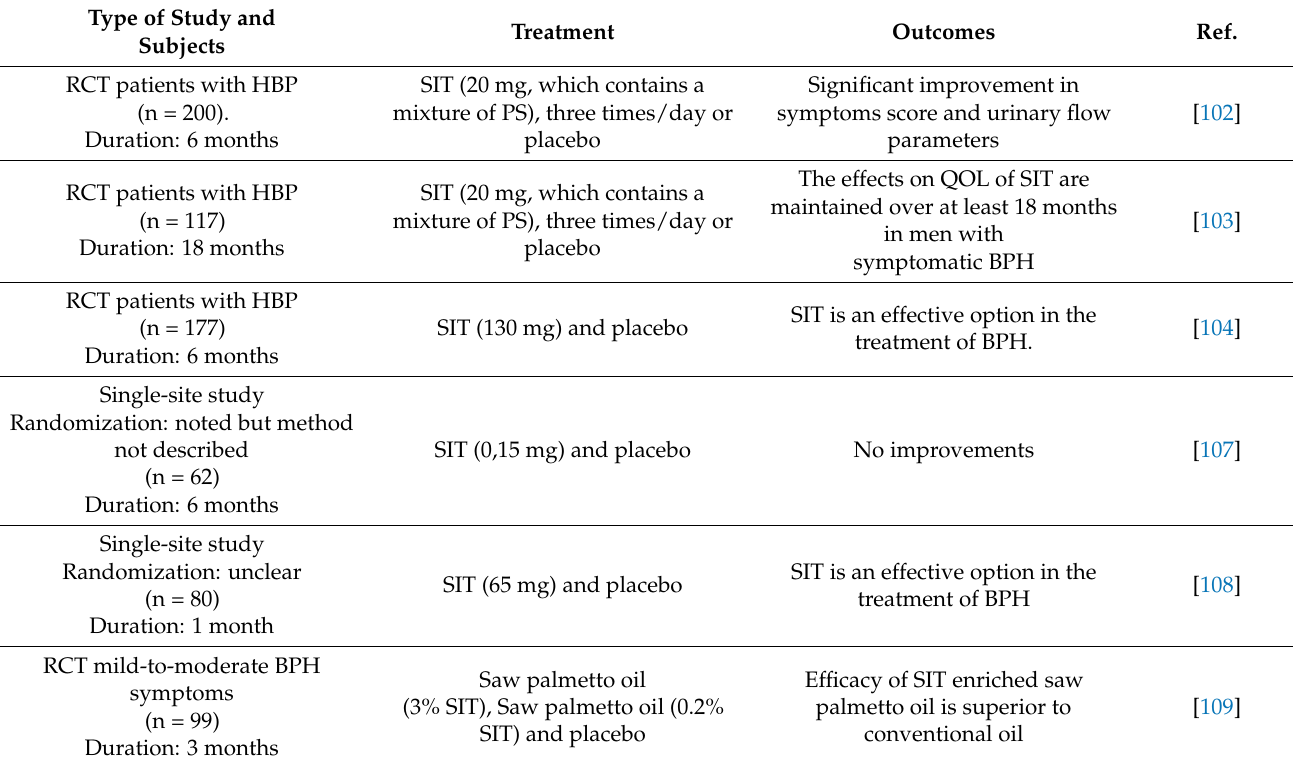
Table 2. Clinical studies with PSs effects in